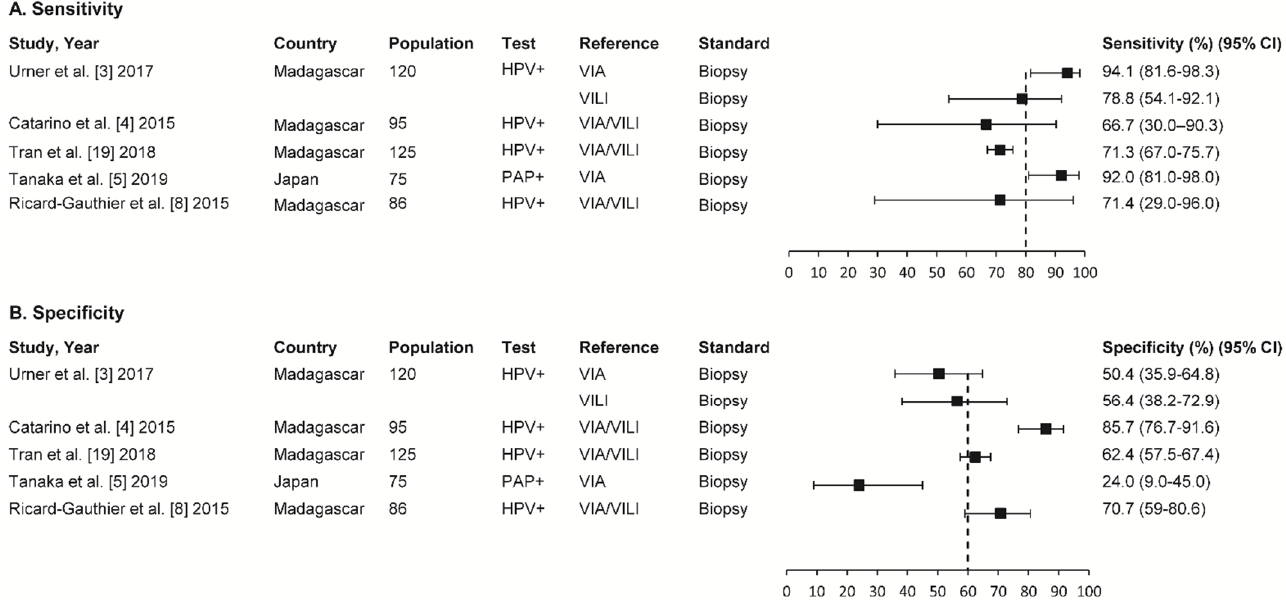
Figure 3. Summary of sensitivity ( A ) and specificity in five studies ( B ). VIA: visual inspection with acetic acid; VILI: visual inspection with Lugol’s iodine; CIN: cervical intraepithelial neoplasia; CI: confidence interval.